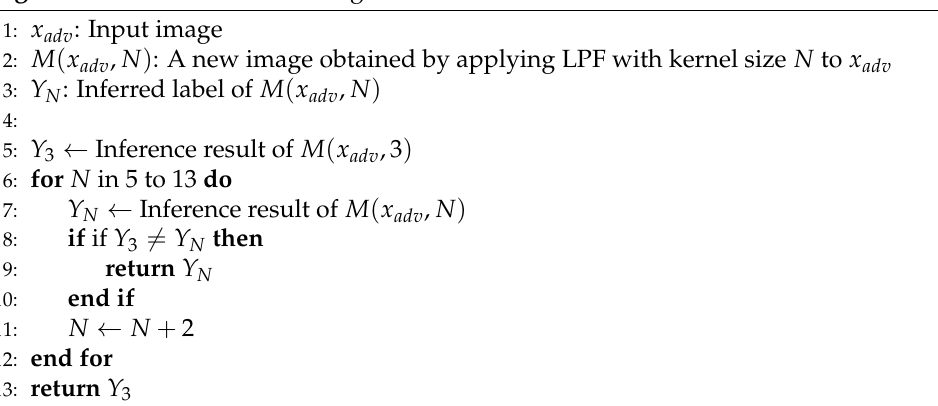
Algorithm 1 Prediction of the original